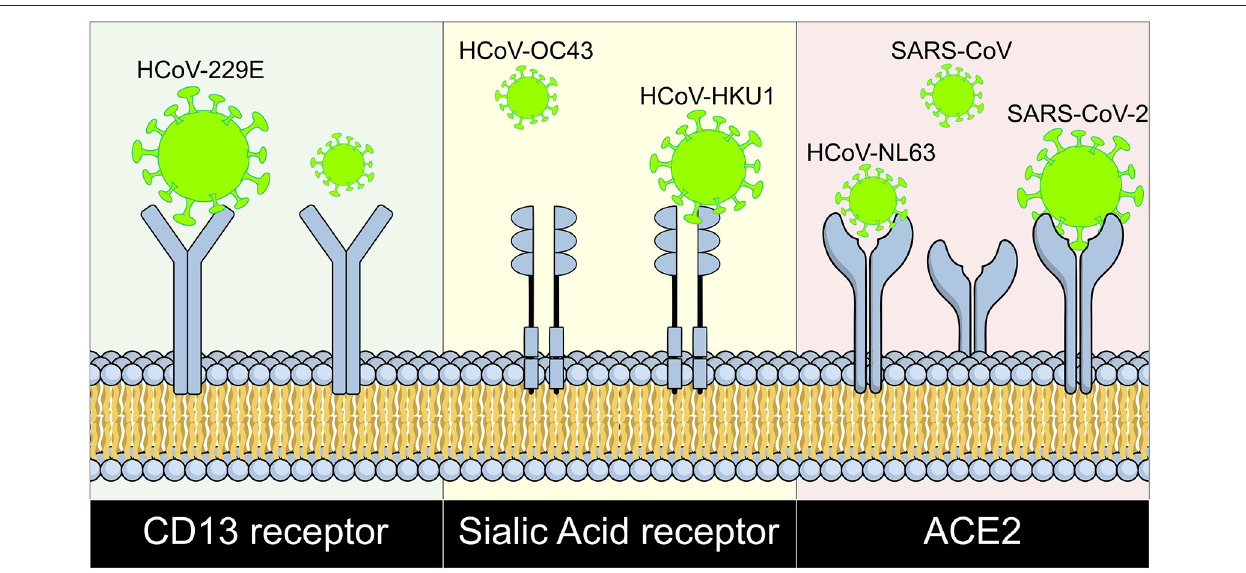
FIGURE 2 | Coronaviruses and their cell surface receptors. The cell receptor for each human coronavirus known is shown. CD13 serves as receptor for HCoV-229E, HCoV-OC43, and HKU1 bind to sialic acid receptors; and ACE2 works as receptor for HCoV-NL63, SARS-CoV, and SARS-CoV-2. HCoV, human coronavirus; SARS, Severe Acute Respiratory Syndrome; CoV, Coronavirus; ACE2, Angiotensin Converting Enzyme 2; CD13, Cluster of differentiation